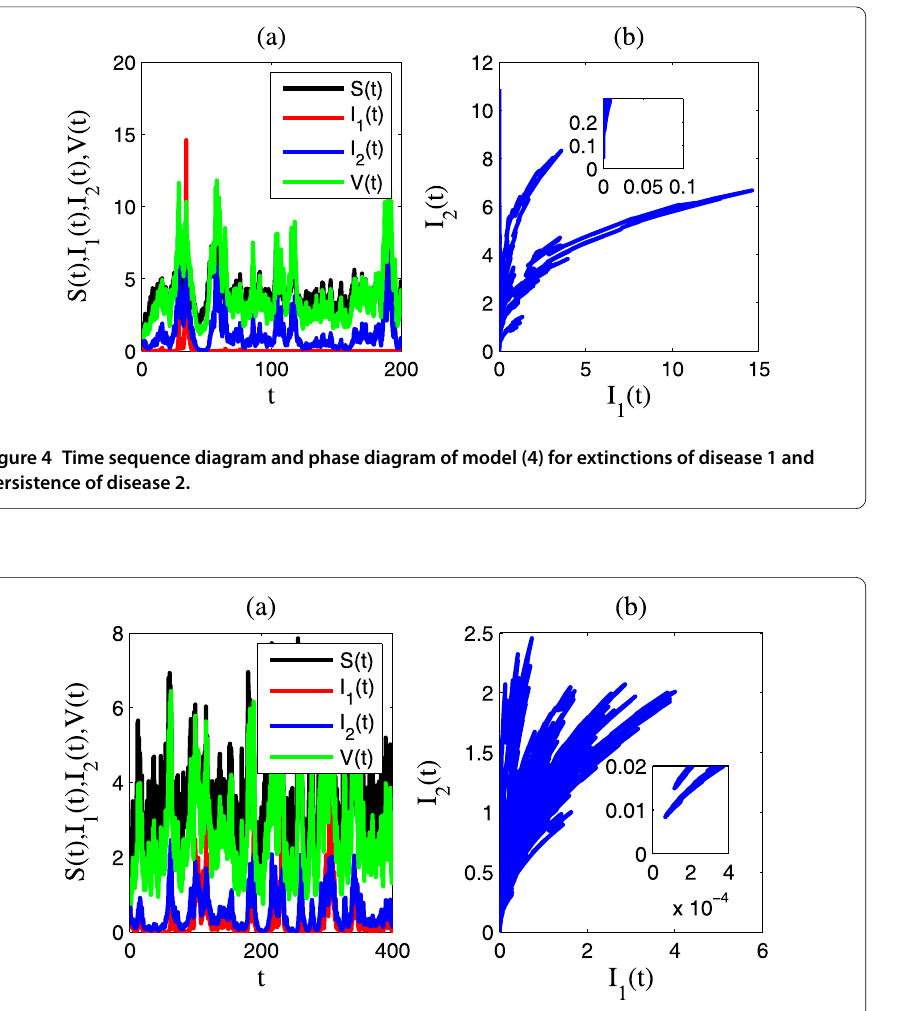
Figure 5 Time sequence diagram and phase diagram of model (4) for persistence of two